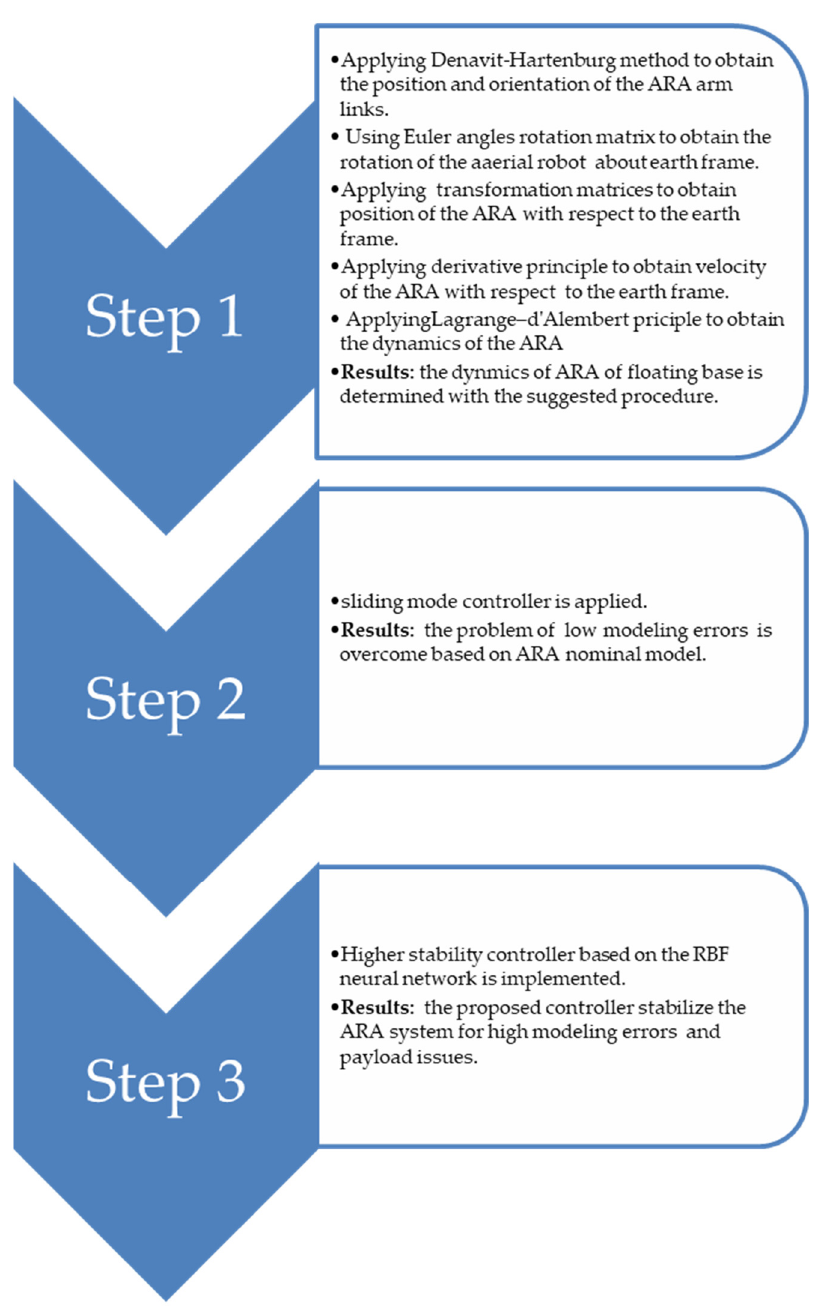
Figure 1. Block diagram of the research and results